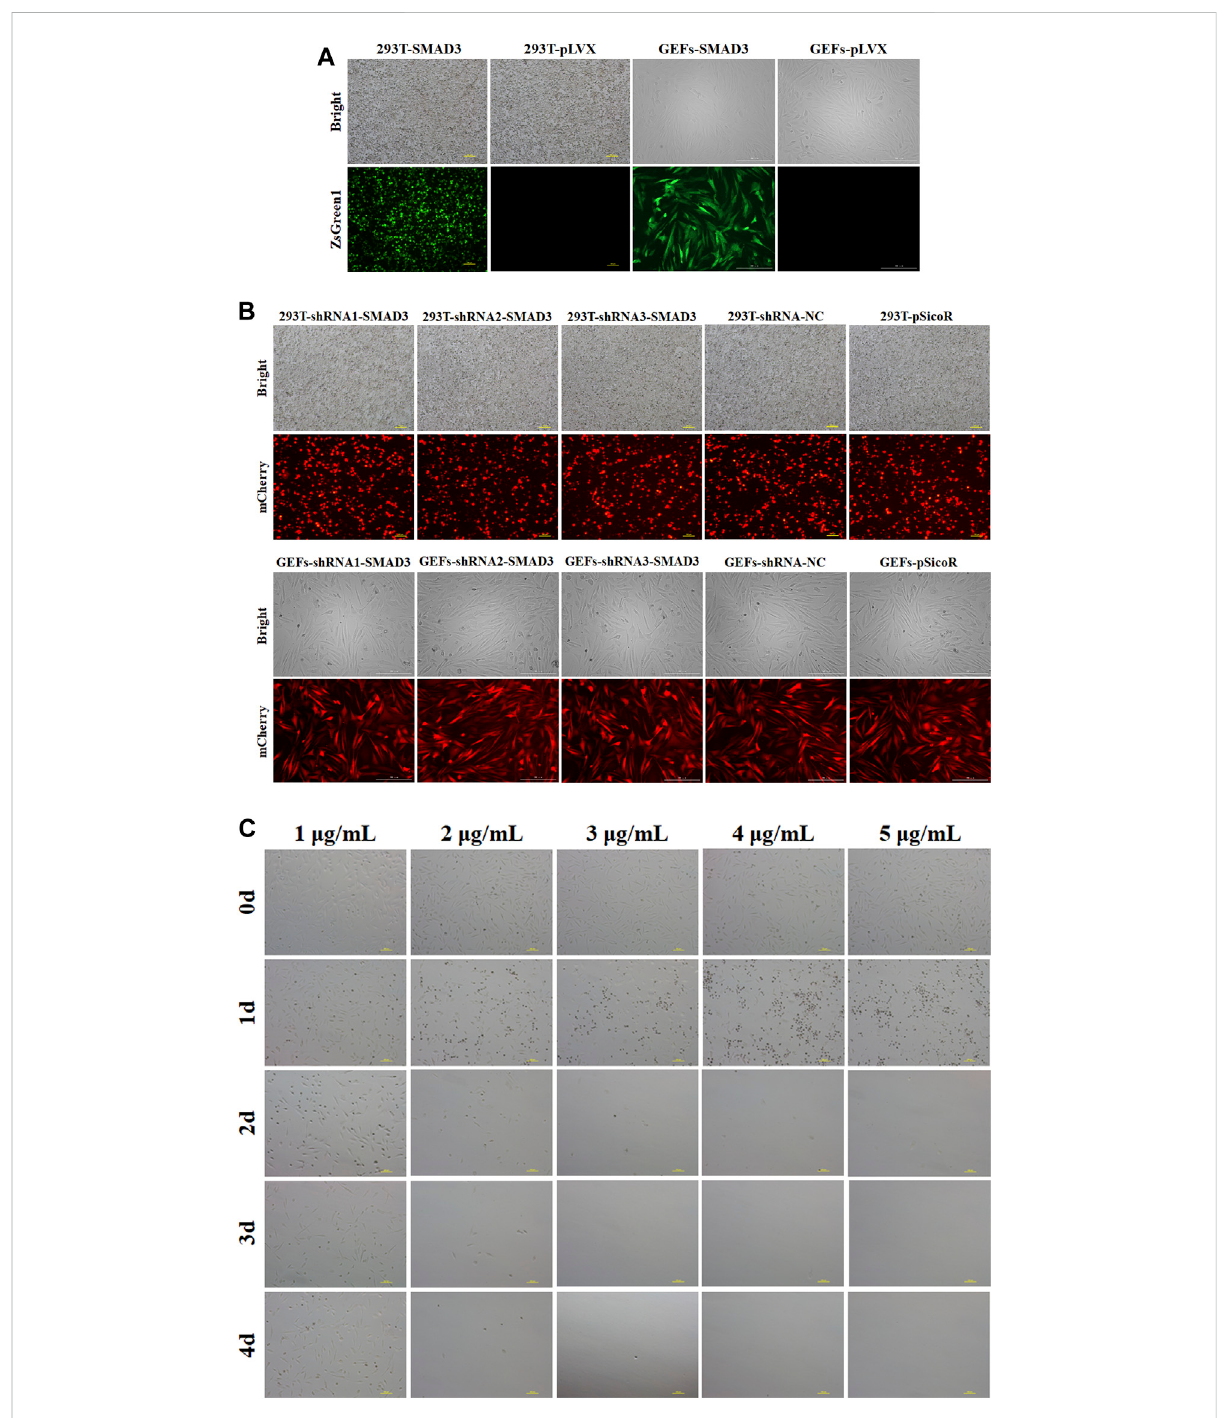
FIGURE 2 Stable overexpression and interference of goat SMAD3 gene cell lines (GEFs-SMAD3 and GEFs-shRNA-SMAD3) were obtained. (A) Fluorescence rate of pLVX-TetOne-SMAD3-Puro packaged lentivirus and virus supernatant infected goat fi broblasts for 48 h. Yellow scale bar, 100 μ m,white scale bar, 200 μ m. (B) Fluorescencerate ofpSicoR-Ef1a-mCherry-shRNA-SMAD3packagedlentivirus and virus supernatantinfected goat fi broblasts for 48 h. Yellow scale bar, 100 μ m, white scale bar, 200 μ m. (C) Screening of suitable concentrations of puromycin. Scale bar, 100 μ